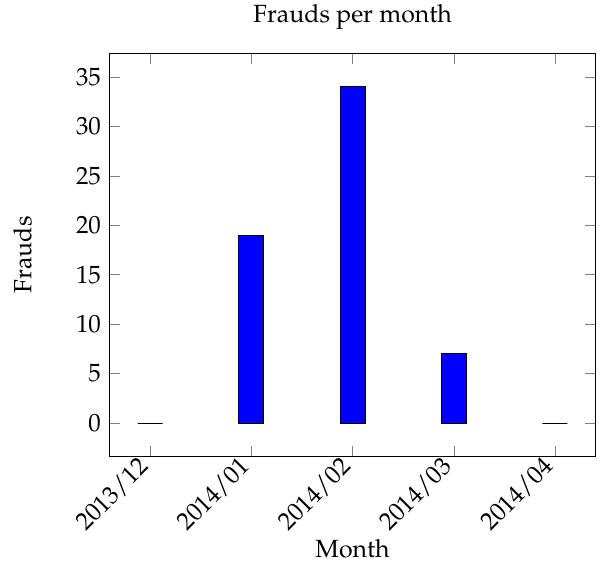
Figure 4. Frauds per month in Dataset